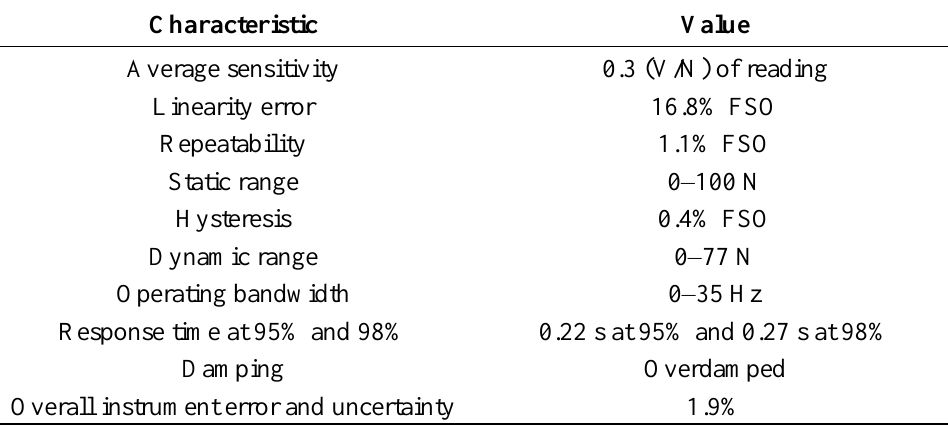
Table 1. Overall characteristics of piezoelectric